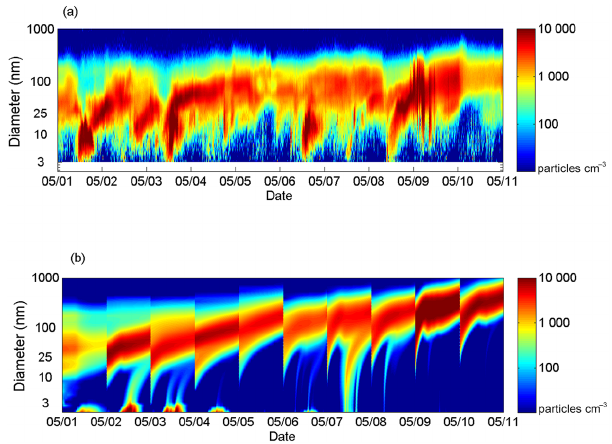
Figure 1. Aerosol size distribution at 2m height during a 10-day pe- riod in May 2013 as (a) measured by the DMPS system and (b) pre- dicted by the model